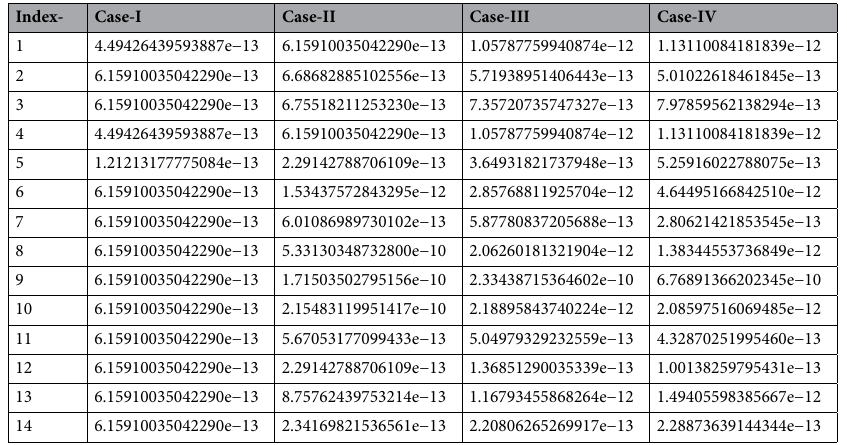
Table 3. Relative error magnitude of the fluid model.